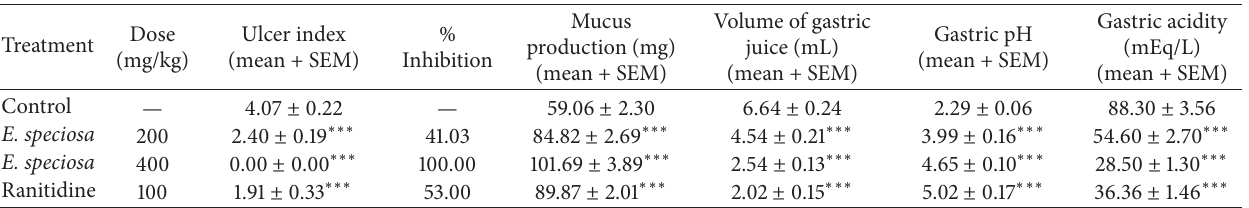
Table 5: Effects of duodenally administered aqueous extract of E. speciosa on gastric ulceration and secretion induced by histamine in rats. Treatment